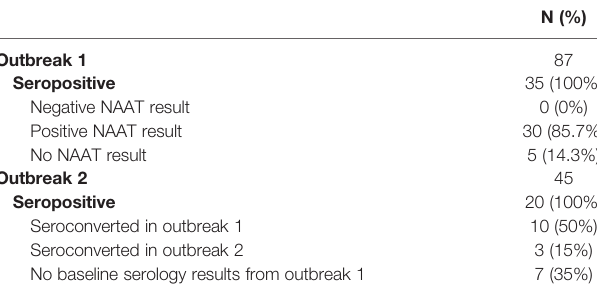
TABLE 2 | Breakdown of seropositive participants based on clinical serology tests.